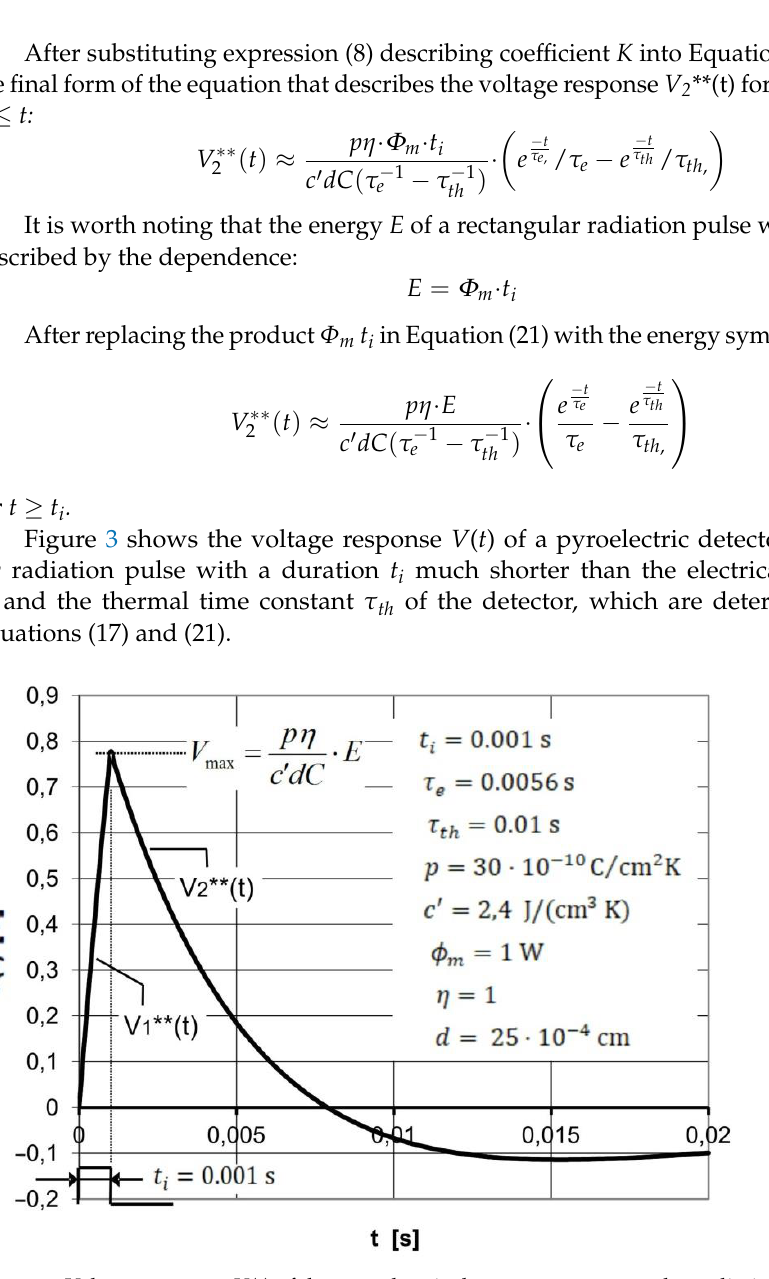
Figure 3. Voltage response V ( t ) of the pyroelectric detector to a rectangular radiation pulse of duration t i significantly shorter than the electrical time constant τ e and thermal time constant τ th of the detector. The physical parameters of the detector are listed in the figure. The V ( t ) function is a piecewise function defined by two sub-functions V 1 **( t ) and V 2 **( t ) described respectively by the Equations (17) and (21), where each sub-function applies to a different time- interval.